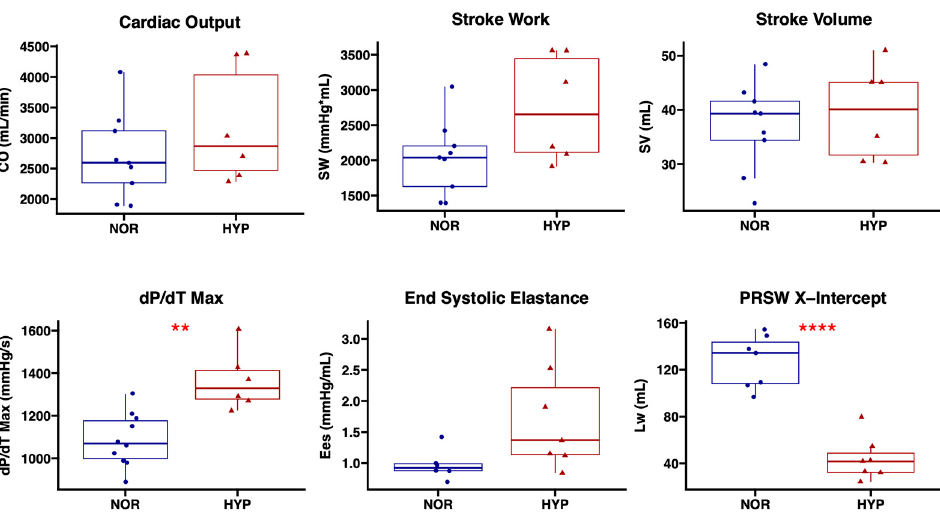
Figure 1. Intramyocardial injection of hypoxia-modified EVs increases left ventricular contractility compared to the injection of normoxia serum-stressed EVs. Swine treated with 50 µg hypoxia-modified (HYP, n = 7) EVs had improved contractility as measured by dP/dt max and the x-intercept (Lw) of the pre-load recruitable stroke work relationship (PRSW) compared to swine treated with 50 µg normoxia serum-starved EVs (NOR, n = 10). There was a trend towards improved stroke work and end-systolic elastance in the HYP group compared to NOR, without changes in cardiac output or stroke volume. Upper and lower borders of box represent upper and lower quartiles; middle horizontal line represents median; upper and lower whiskers represent maximum and minimum values. CO, cardiac output; SW, stroke work; SV, stroke volume; dP/dT, change in pressure over change in time; Ees, end-systolic elastance. ** p < 0.01, **** p < 0.0001.